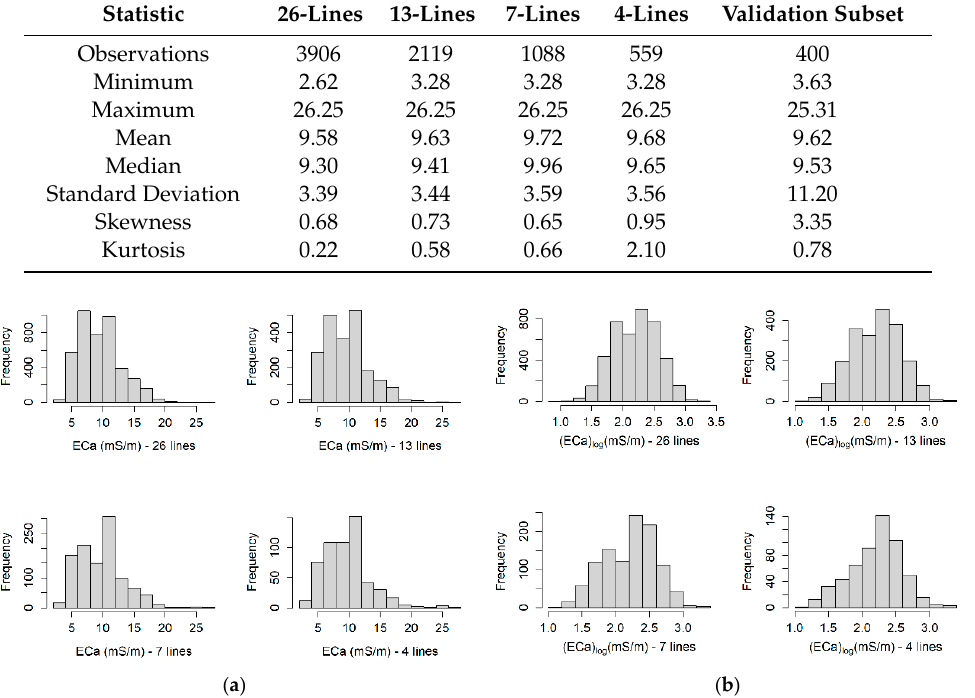
Figure 4. Histograms for soil ECa datasets for the different numbers of transect lines (i.e., 26, 13, 7, and 4), considering: ( a ) actual values; and ( b ) natural logarithm